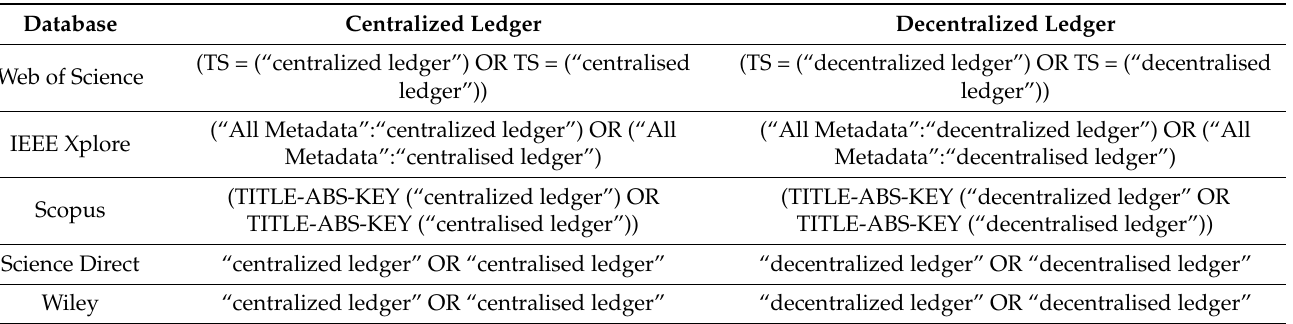
Table 1. Search queries in scientific databases.